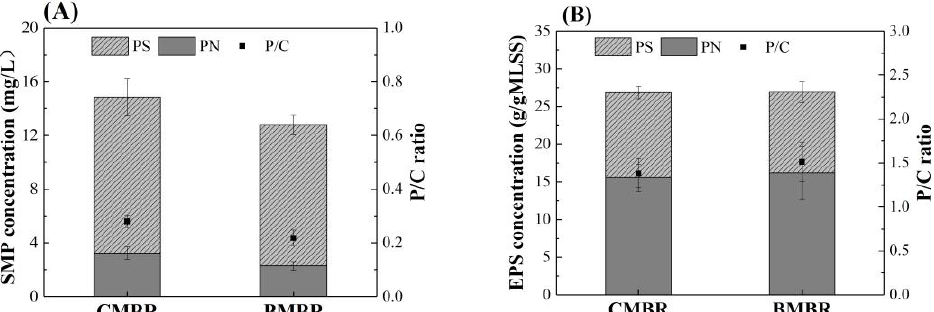
Figure 2. The compositions of ( A ) EPS and ( B ) SMP in the mixed-liquor suspension from conventional MBR (CMBR) and biochar MBR (BMBR).